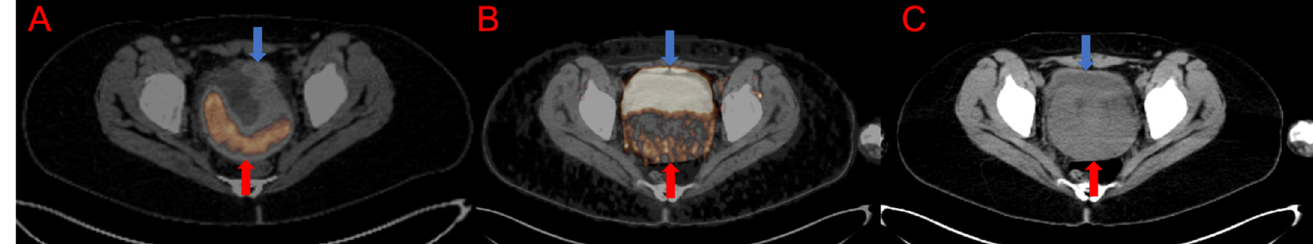
Figure 2. A 36-year-old female patient with FIGO stage II, squamous cell carcinoma of the cervix. ( A ). 18 F-FDG PET transaxial image through the pelvis demonstrating uptake in the primary tumor (red arrow) with minimal uptake in the urinary bladder (blue arrow) ( B ). 68 Ga-Nitroimidazole PET transaxial image through the same plane exhibiting spatially incongruent uptake with inhomogeneous uptake in parts of the tumor (red arrow) and intense activity in the urinary bladder (blue arrow). ( C ) is the corresponding CT only image in the same plane with target organs marked with arrows. The fractional hypoxic volume was 36%.